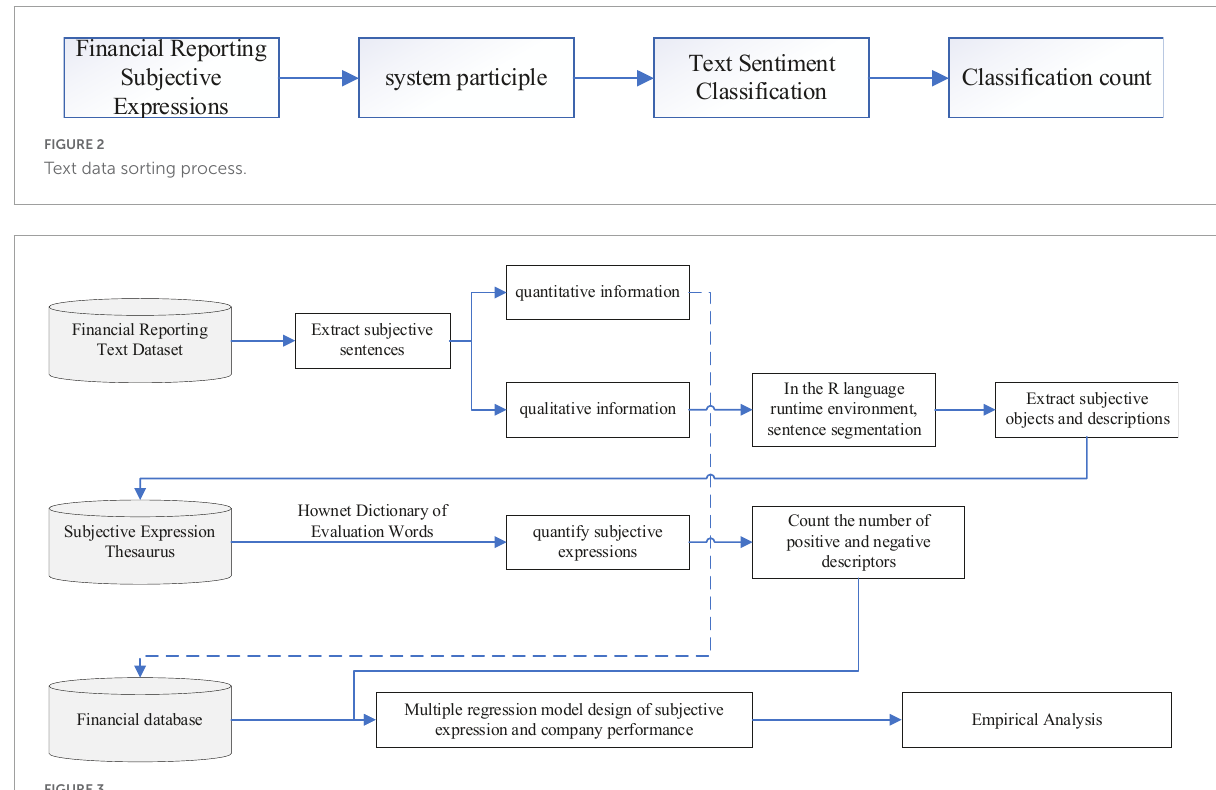
FIGURE2 Text data sorting process.